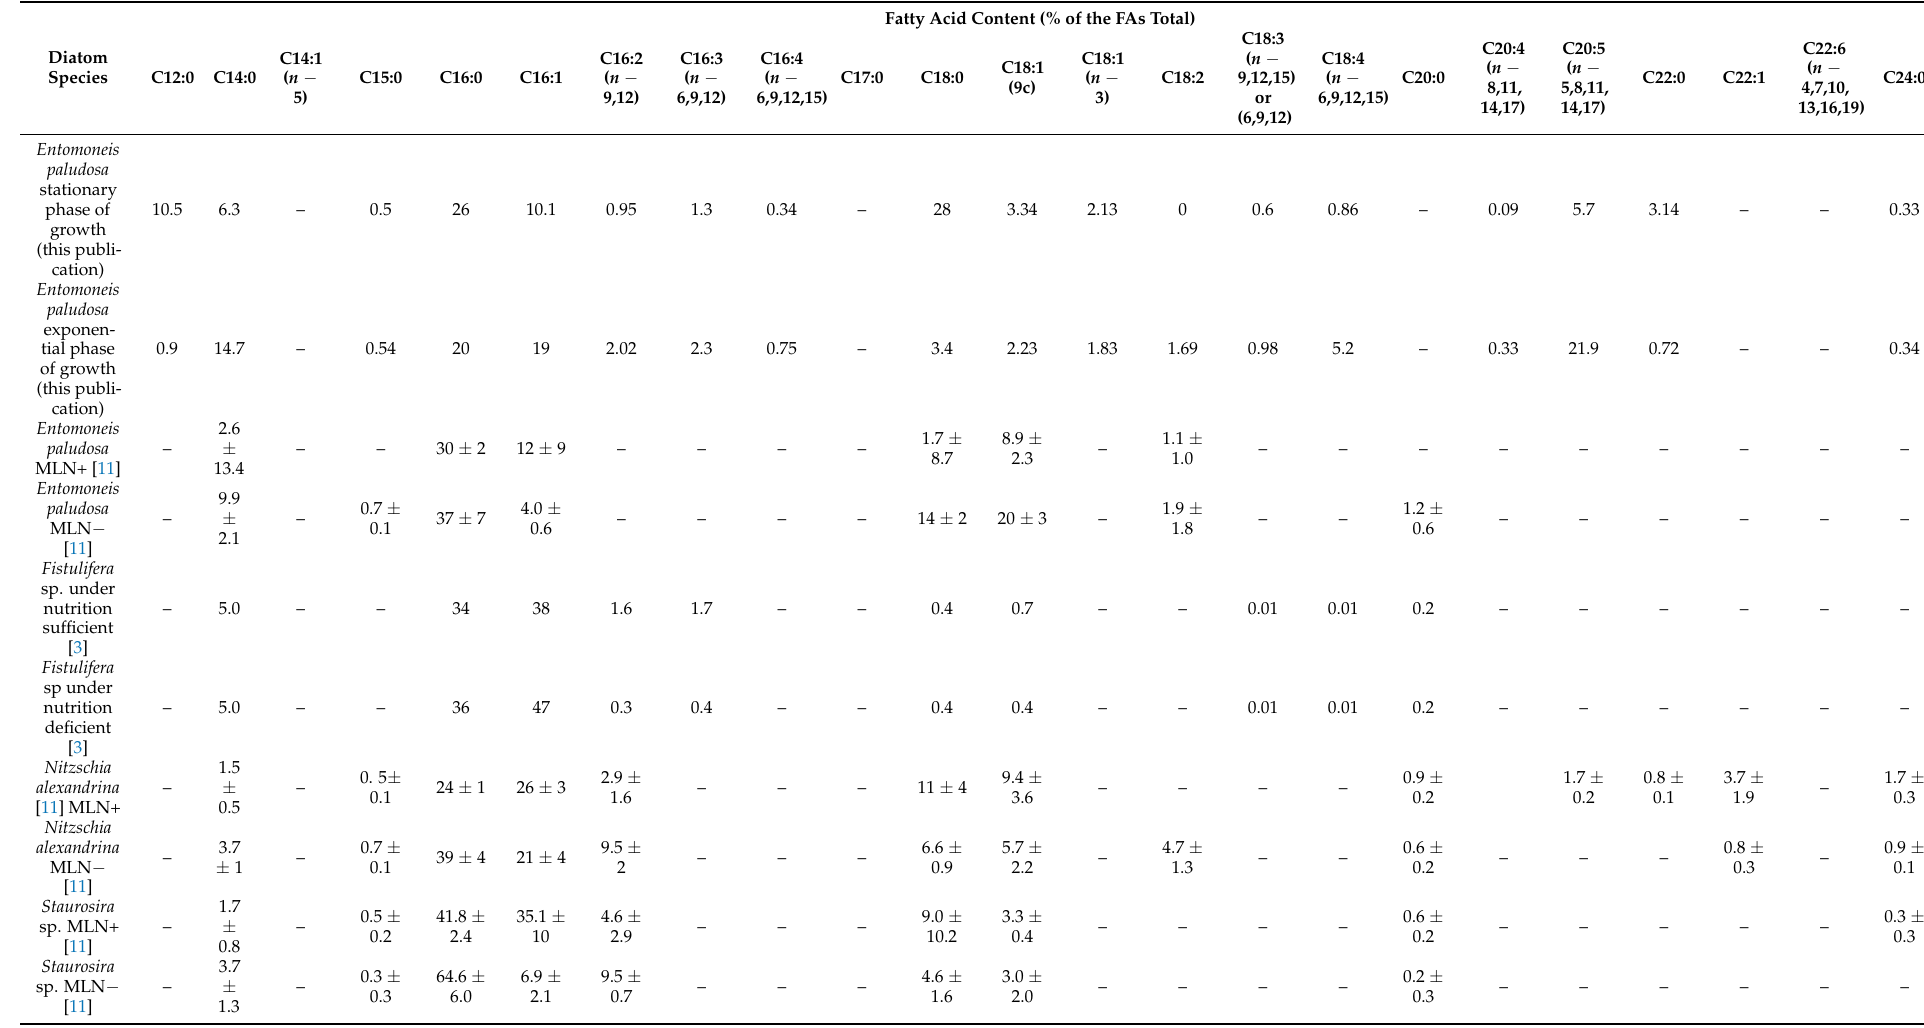
Table 2. Comparison of the fatty acid composition in different species of